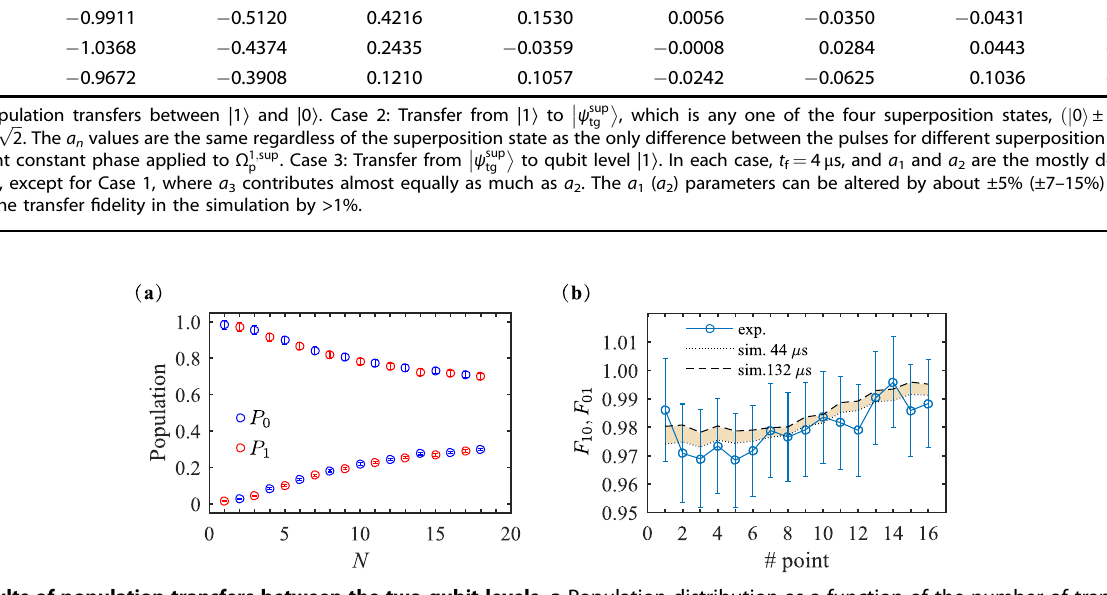
Fig. 3 Results of population transfers between the two-qubit levels. a Population distribution as a function of the number of transfers ( N ) performed in experiments. The error bar is calculated using the 100 experimental data points as described in “ Methods ” under the Data evaluation part. The same rule applies to all the other fi gures. b The calculated transfer fi delity between |1 〉 and |0 〉 in experiments (blue circles) and simulation (shaded area). The fi rst four data points were used for evaluating the transfer fi delity as Eqs. (1) and (2) apply only for small N ( ≤ 6). Simulations were done at two different coherence times, 44 μ s and 132 μ